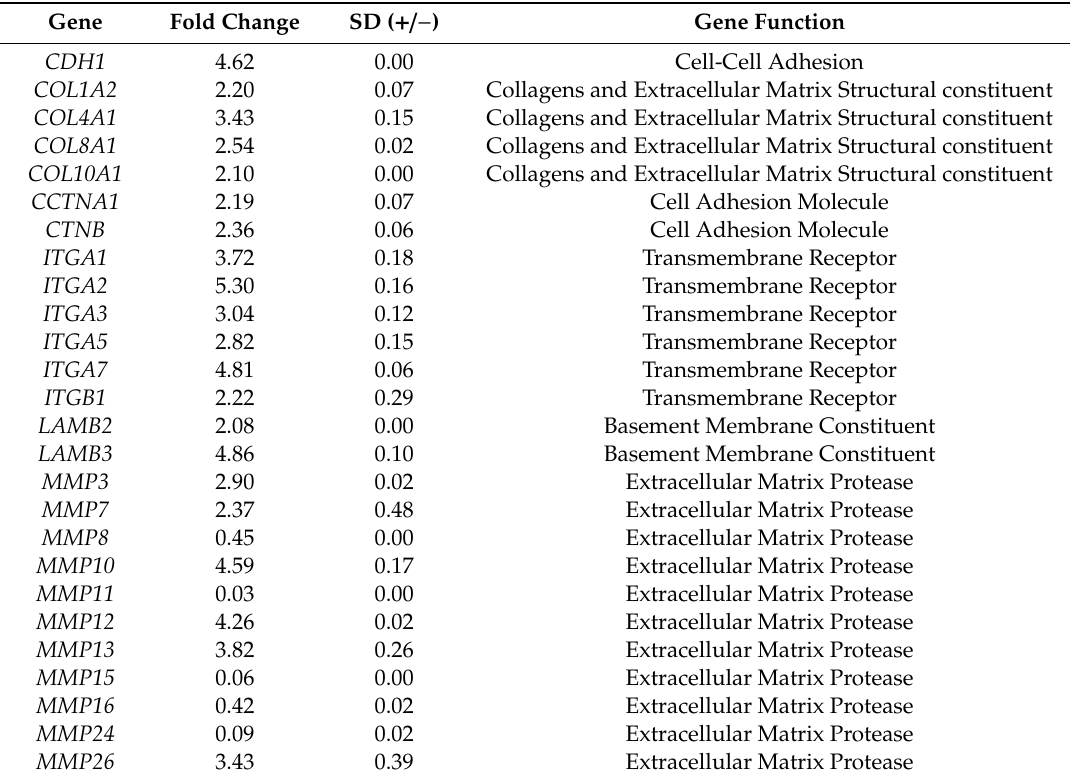
Table 3. Significant gene expression levels after 24 h of treatment with mycophenolate, as compared with untreated cells.